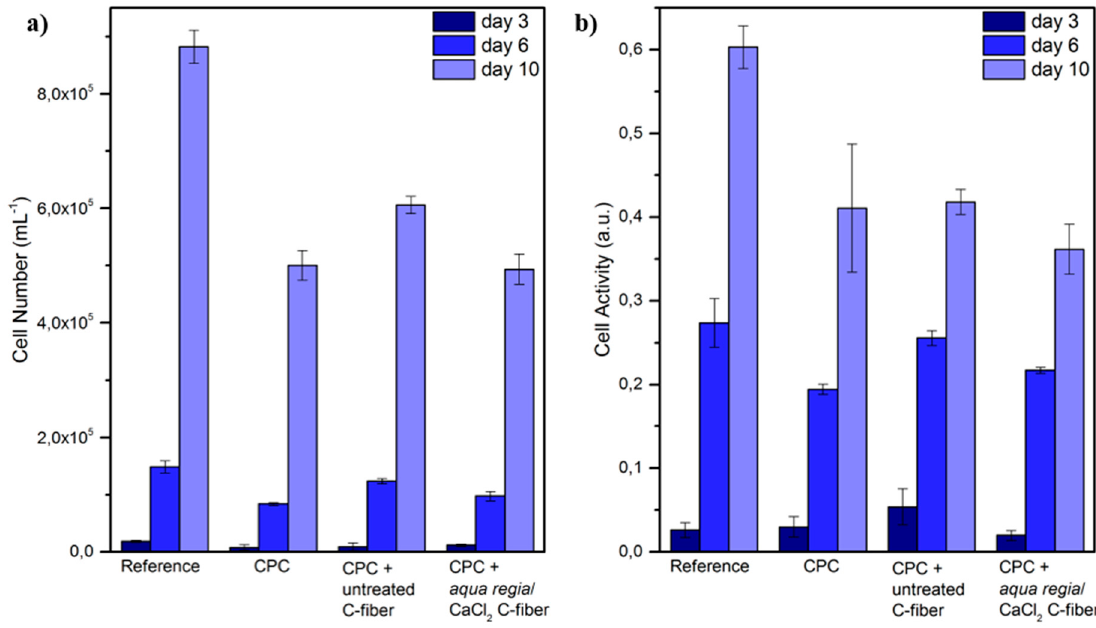
Figure 6. ( a ) Cell number and ( b ) cell activity of osteoblast-like cell line MG63. Cells were cultivated with medium from dissolution tests over 10 days.